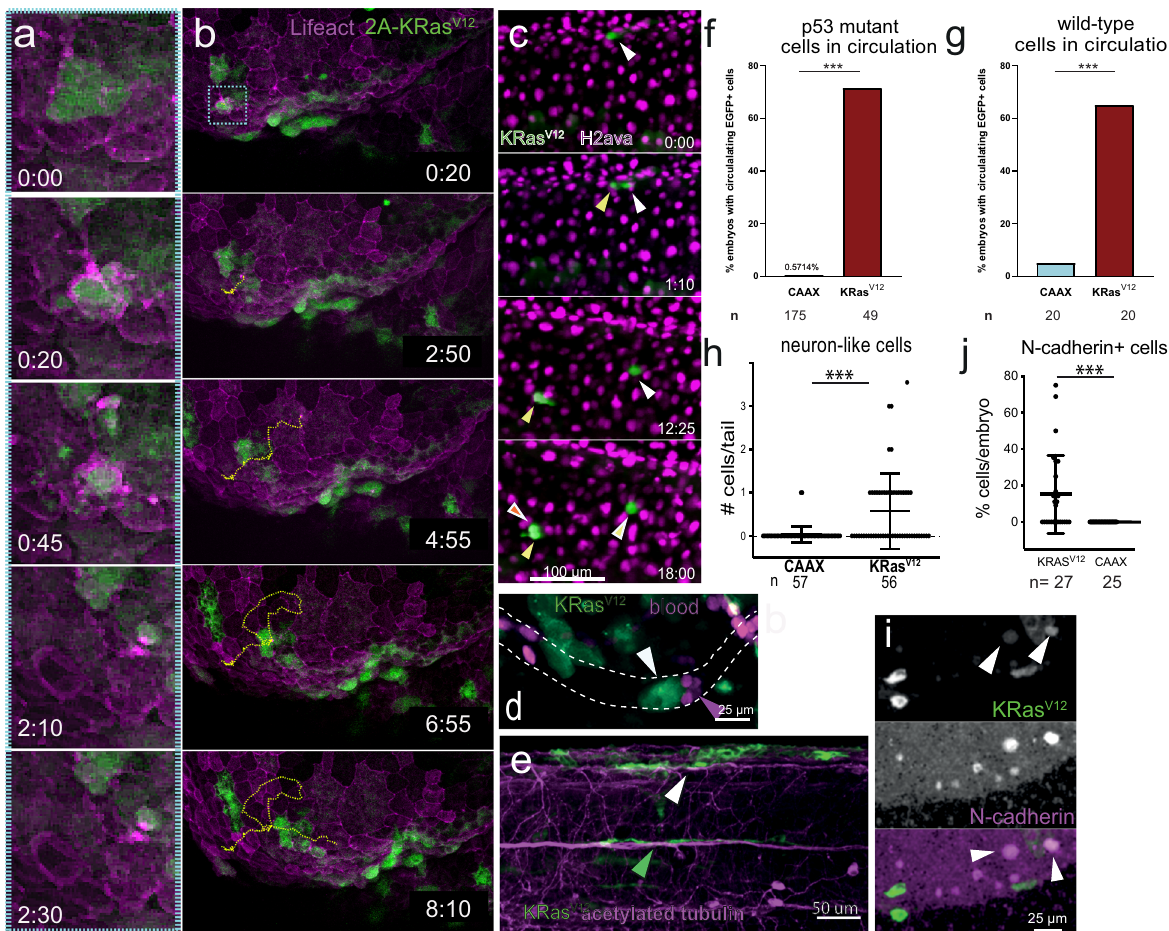
Fig. 3 KRas V12 cells invade by BCE, migrate, divide, and adopt new plasticity. b Stills from Supplementary Movie 8 of a basally extruding EGFP-T2A- KRas V12 cell from a periderm:Lifeact-mCherry reporter line, where ( a ) is a zoom inset (blue) for only the fi rst 2.5 hrs, showing BCE and migration, tracked with dashed yellow line. c Stills from Supplementary Movie 11 of an invaded EGFP-KRas V12 cell dividing in a h2afva :h2afva-mCherry reporter line, where white, yellow, and red arrowheads indicate daughter cells from the two cell divisions. d Stills from Supplementary Movie 14 showing an EGFP-KRas V12 cell blocking fl ow of gata1 :mCherry-labelled blood cells. In all cases, movies were from 24-48 hpf with (hh:mm). Percentage of CAAX or T2A-KRas V12 embryos with circulating EGFP + cells in p53mut ( f ) and wild-type ( g ) zebra fi sh as mean + SEM, *** P < 0.001 by a Fisher Exact test, n = embryos. e T2A-KRas V12 cells with neuron-like morphology, with white arrowhead indicating co-staining with acetylated tubulin and green arrowhead aligning along a neuron. h Neuron-like EGFP-CAAX or T2A-KRas V12 cells per n embryos (beneath), *** P < 0.001 by a Mann – Whitney test. i N-cadherin immunostaining indicating some dt-KRas V12 (arrowheads) adopt this mesenchymal marker. j Percentage of invaded cells that are N-cadherin + per embryo, as mean ± SEM, where *** P < 0.001 by a Mann – Whitney test. All graphs were from embryos fi xed at 48 hpf. Source data are provided as a Source Data independent of primary masses. Whereas p53 and cMyc altera- City, UT, USA) using the BP Clonase II Enzyme mix (Thermo Fisher Scienti fi c). Using BP recombination, we also cloned into pME the following contructs: human tions have been associated with later stages of cancer, they do not drive invasion in our system. We fi nd that KRas-transformation directly causes cell invasion, while p53 mutation enables their survival. While our zebra fi sh model may endow invading cells with more plasticity than might exist in adult organs, we believe that this ability to view invasion live from native epithelial sites reveals new insight that could account for the intrinsic metastatic and stromal nature of KRas-driven tumours. In addition, understanding how cells invade could shift treatment modalities. For instance, screening for cytoplasmic epithelial markers in circulating tumour cells combined with preventative therapies could ward off metastatic disease. Methods Molecular biology . All cloning procedures followed protocols described previously 34 the Invitrogen Gateway Technology Manual, and the Tol2kit wiki (http://tol2kit.genetics.utah.edu/index.php/Main_Page). We cloned the krt4 pro- with the University of Utah - Centralized Zebra fi sh Animal Resource and the moter sequence into p5E (gift from David Grunwald, University of Utah, Salt Lake